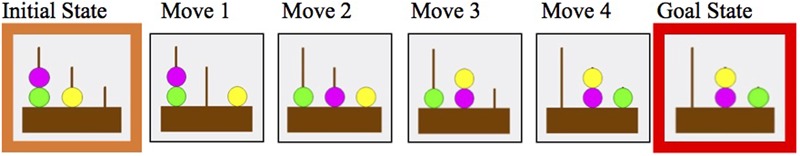
The ToL task. Example of a practice ToL trial showing the initial state position and the goal state position. Beads were red, blue, and green for test trials. All trials were four-move problems.